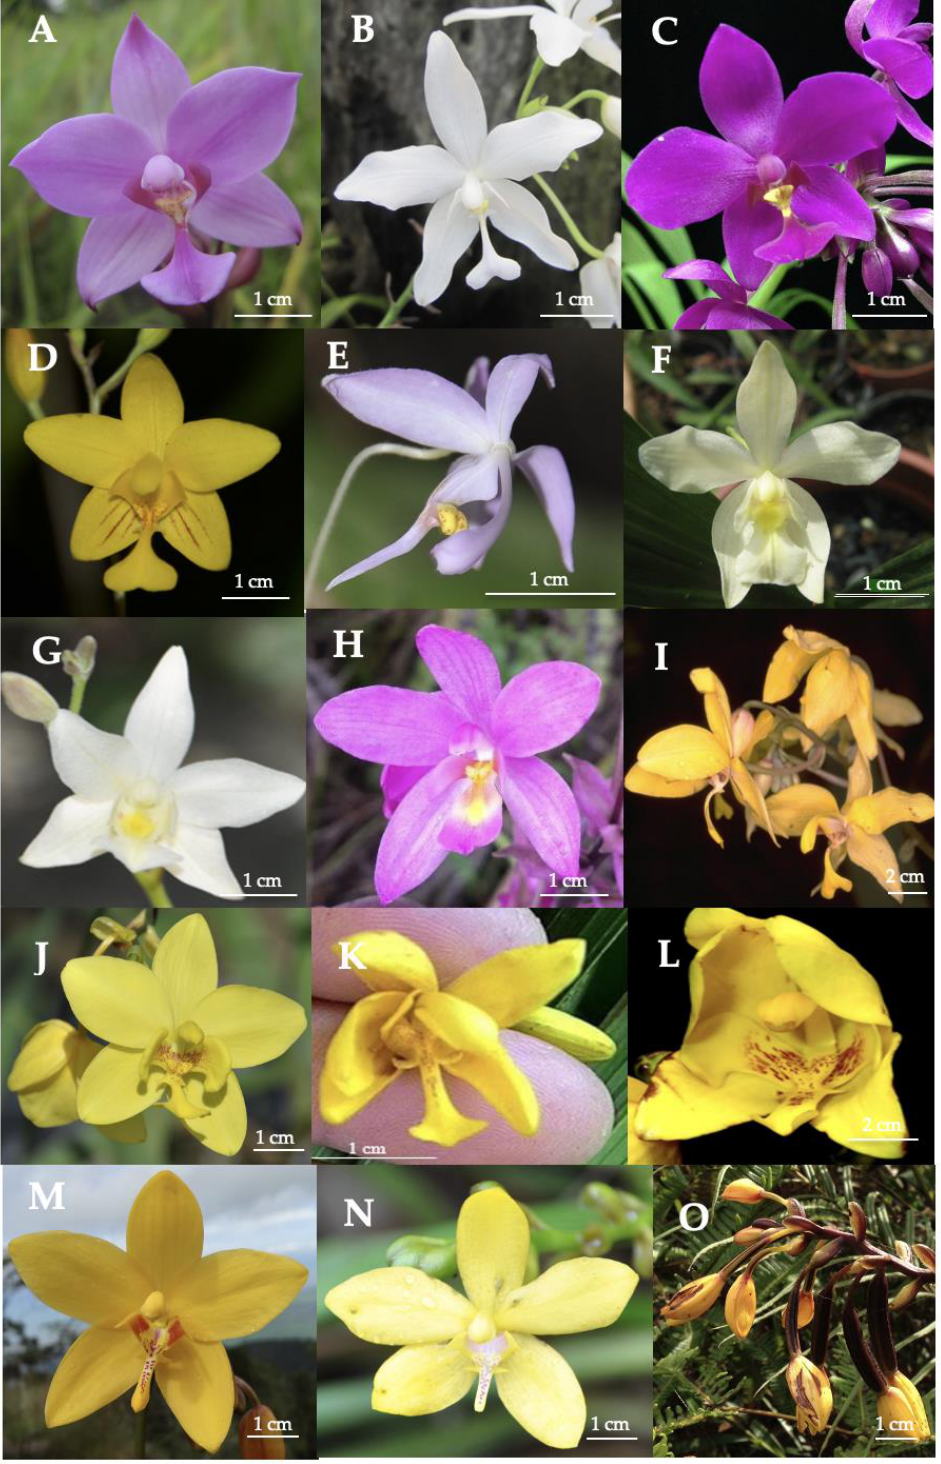
Figure 1. The species and infraspecific taxa of Spathoglottis from Peninsular Malaysia, Borneo, Thailand, Irian Jaya and the New Caledonia used in this present work: ( A ) S. plicata Blume; ( B ) S. plicata var. alba ; ( C ) S. unguiculata (Labill.) Rchb.f.; ( D ) S. affinis de Vriese; ( E ) S. hardingiana C.S.P.Parish & Rchb.f.; ( F ) S. pubescens Lindl.; ( G ) S. eburnea Gagnep.; ( H ) S. parviflora Kraenzl.; ( I ) S. gracilis Rolfe ex Hook.f.; ( J ) S. kimballiana Hook.f.; ( K ) S. kimballiana var. kimballiana ; ( L ) S. kimballiana var. angustifolia Ames; ( M ) S. aurea Lindl.; ( N ) S. microchilina Kraenzl.; and ( O ) cleistogamous flowers of S. aurea . Photos: Farah Alia Nordin and Peter O’ Byrne (I, K and L: KIP1266f and